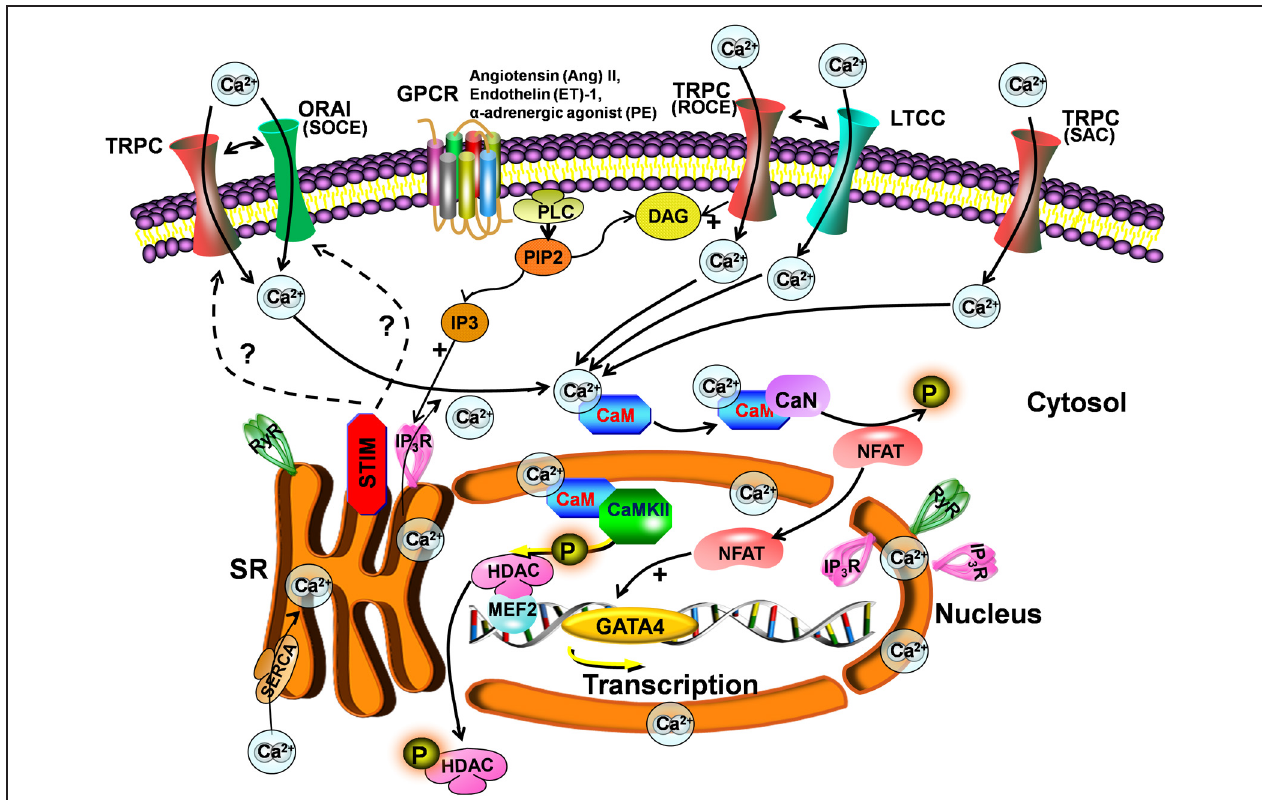
FIGURE 1 | Scheme for the TRPC signaling pathway in hypertrophy. Stimulation of Gq-protein coupled receptors (GPCR) and subsequent activation of PLC leads to IP 3 and DAG generation. DAG directly activates TRPCs and induces receptor-operated Ca 2 + entry (ROCE), causing membrane depolarization and secondarily activating LTCCs. IP 3 activates